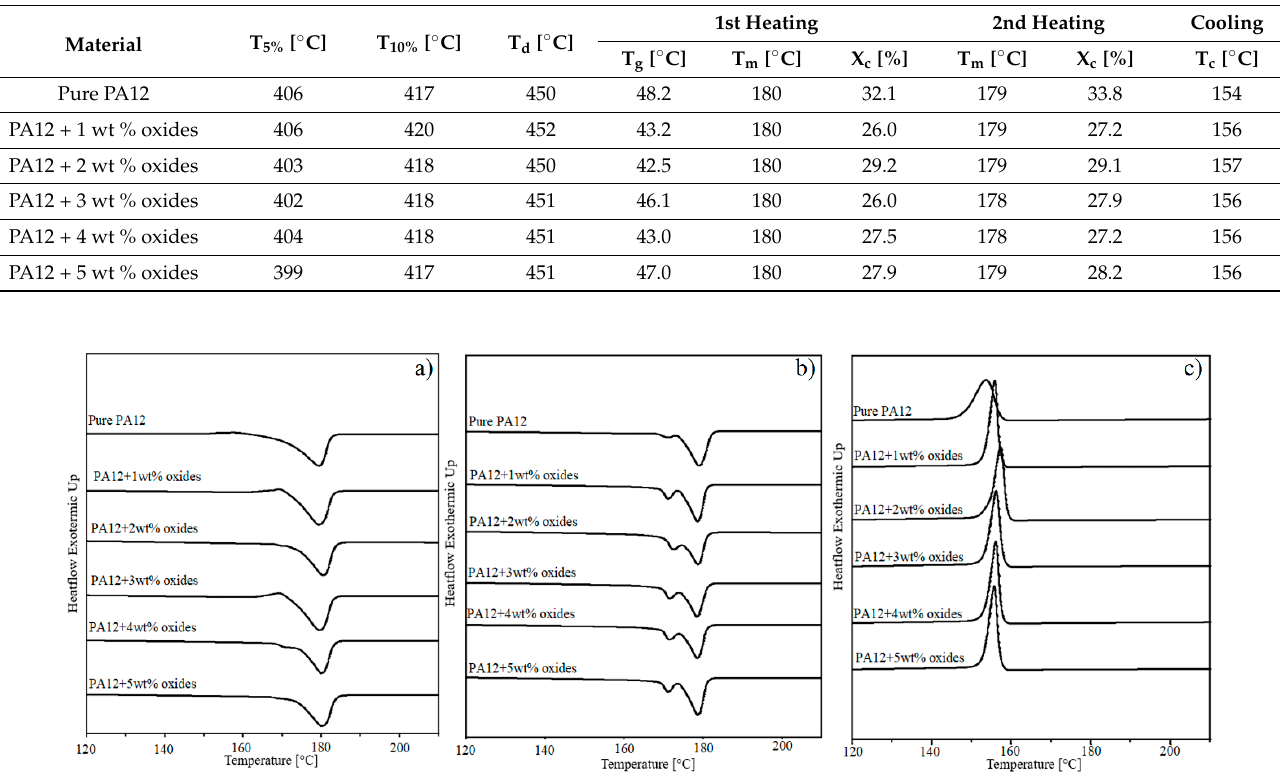
Figure 4. DSC curves for studied materials; ( a ) first heating; ( b ) second heating; ( c )